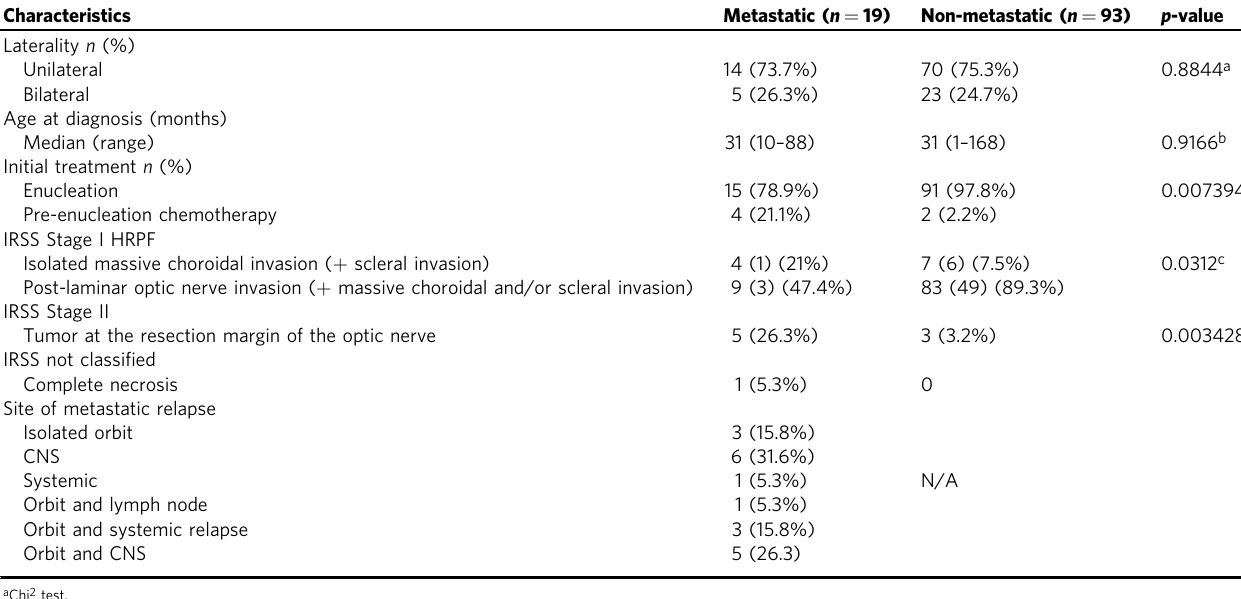
Table 2 Clinical and pathological characteristics of an additional series of 112 primary tumors presenting HRPFs.